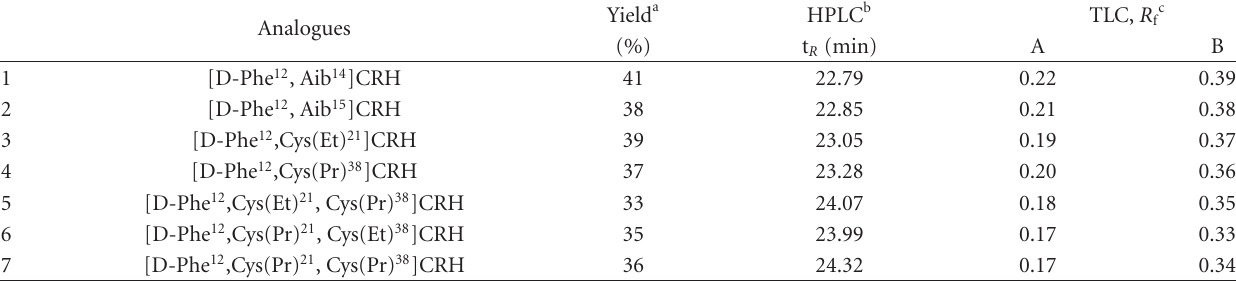
Figure 1: (a) Analytical HPLC chromatogram of crude analogue [D-Phe 12 , Cys(Pr) 21 , Cys(Pr) 38 ]CRH previously chromatographed on a semipreparative C18 column. (b) Analytical HPLC chromatogram of analogue [D-Phe 12 , Cys(Pr) 21 , Cys(Pr) 38 ]CRH upon rechromatography on the same column. (c) Mass spectra of analogue [D-Phe 12 , Cys(Pr) 21 , Cys(Pr) 38 ]CRH resulting from ESI-MS analysis [MW calc = 4785 . 58; (M + 4) obs4+ /4 = 1198.2; (M + 3) obs3+ /3 = 1596.5]. Table 2: Physicochemical properties of h/r-CRH analogues used in the present